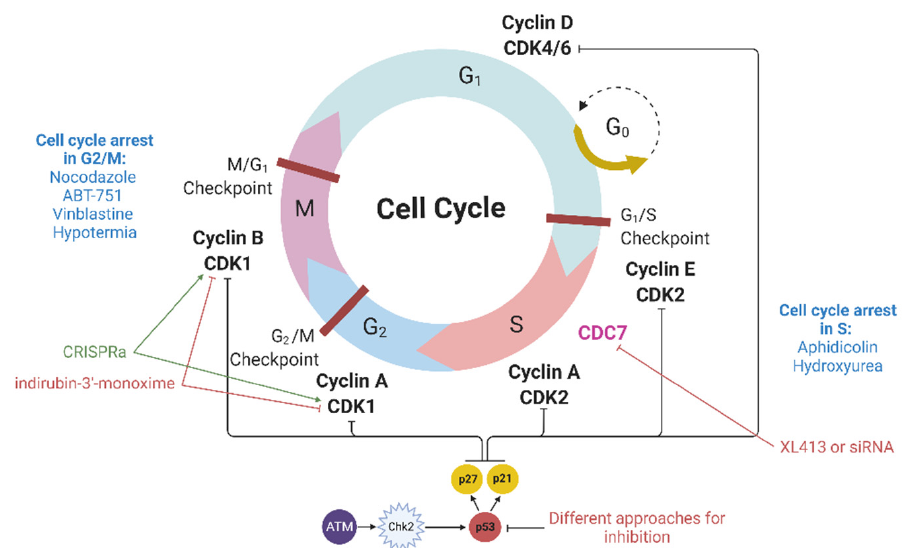
Figure 2. Mechanism of p53-mediated cell cycle arrest and possible approaches to influencing the cell cycle. DSBs activate ATM kinase and Chk2; this complex phosphorylates p53, which promotes the expression of p21 and p27. The latter binds and inhibits cyclin and cyclin-dependent kinase complexes, leading to cell cycle arrest in the G1/S phase as well as in the M/G1 and G2/M phases. ATM—serine/threonine kinase mutated in ataxia-telangiectasia, Chk2—checkpoint kinase 2. Detailed explanations are provided in the text.